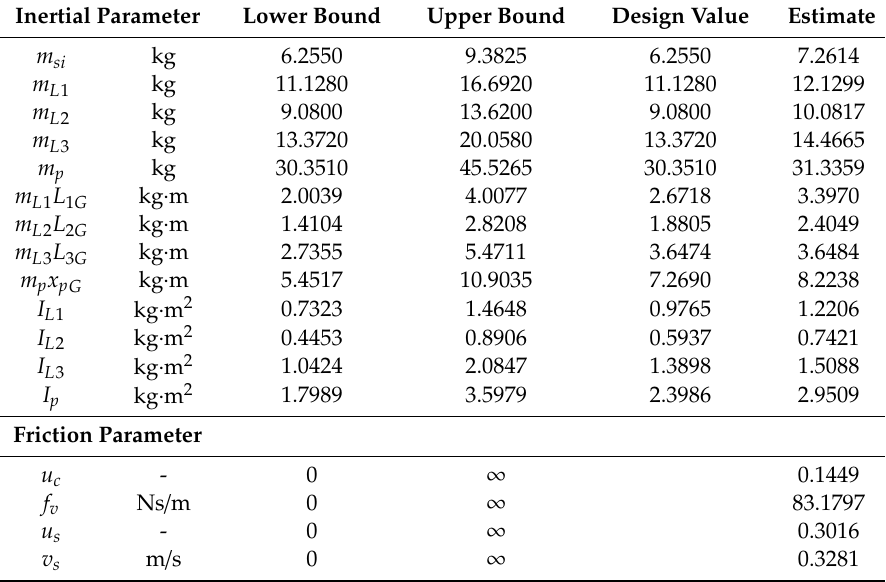
Table 1. Estimates of the inertial and friction parameters using a nonlinear model with varying